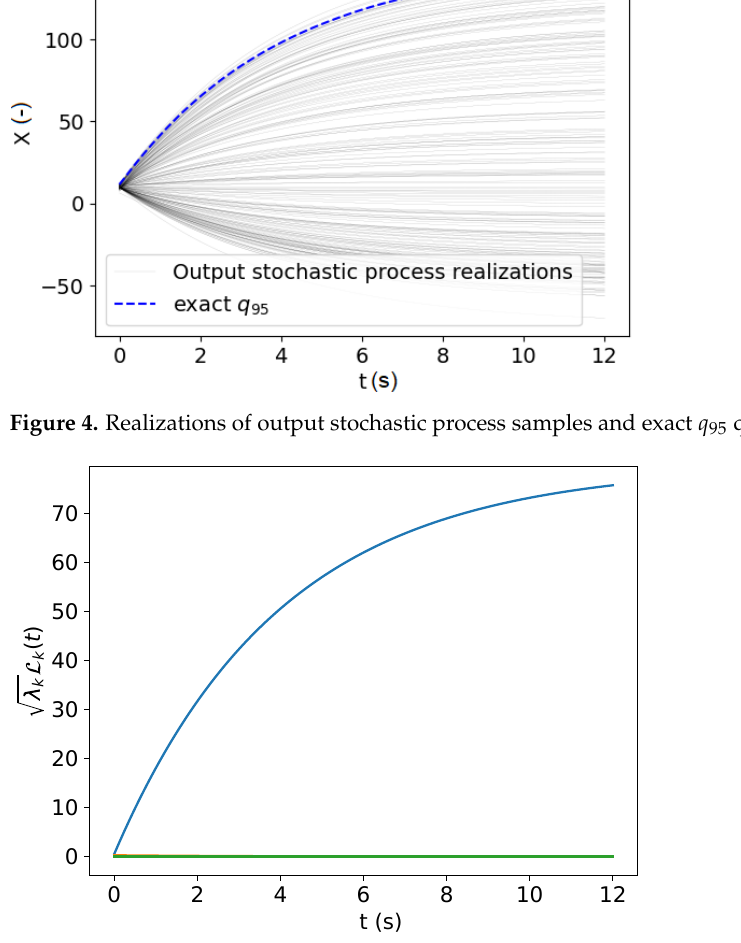
Figure 5. 13 scaled KL modes for the output stochastic